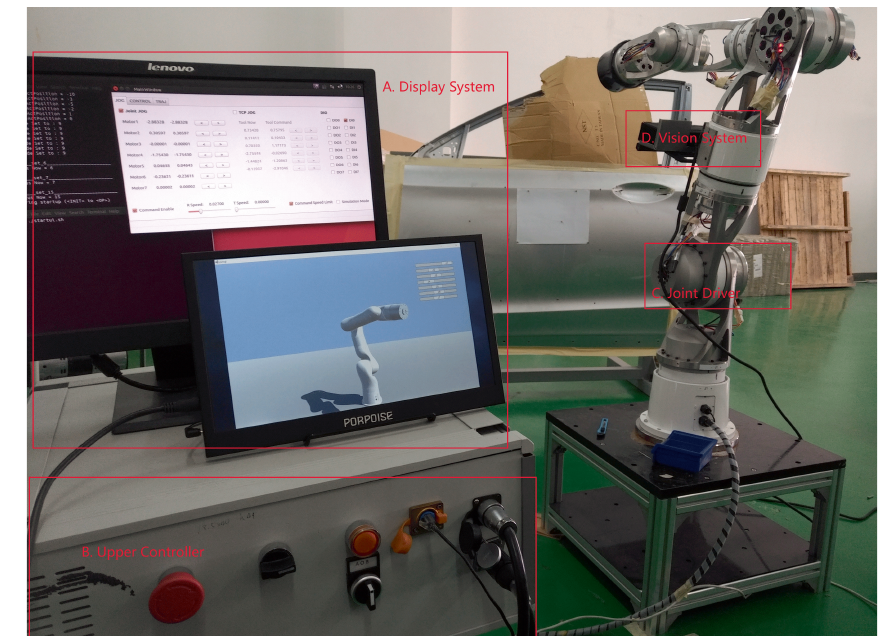
Figure 3: The SIA-SmartPainting system: (a) the display system, (b) the upper controller, (c) the joint driver, (d) the vision